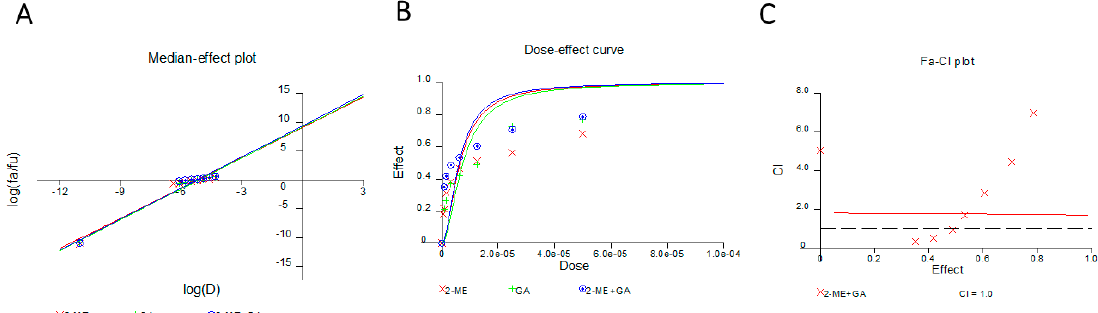
Figure 2. Antagonistic effect between 2-ME and GA. Anti-proliferative potential of 2-ME (red line), GA (green line), and the combination of both compounds (blue line) was determined by MTT assay as described above. Consequently, median-effect plot ( A ), dose–effect curve ( B ), and Fa-CI plot ( C ) were evaluated by CalcuSyn software. Values are the mean ± SE from three independent experiments.